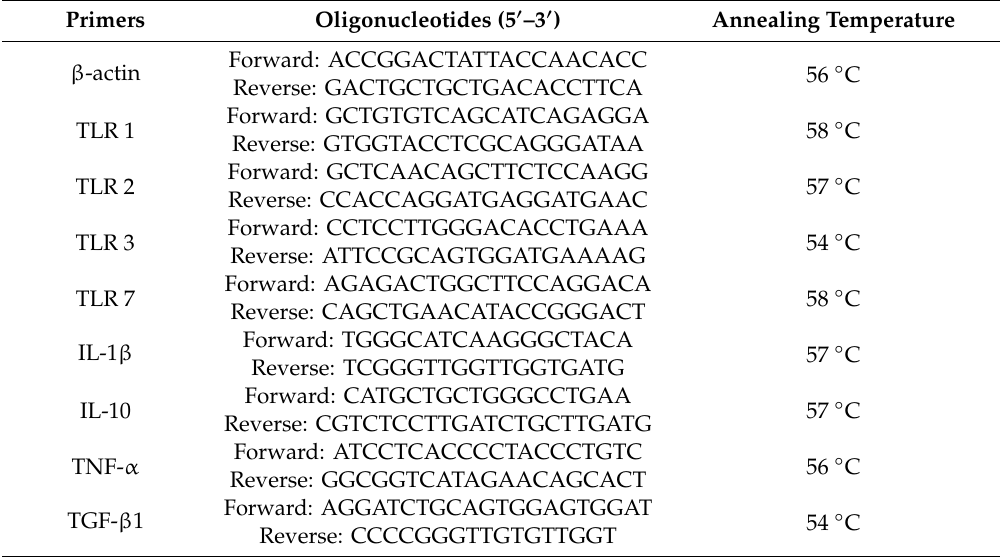
Table 3. Primers used in the qRT-PCR for quantification of TLRs and cytokine mRNA expression. Primers Oligonucleotides (5 (cid:48) –3 (cid:48) ) Annealing Temperature Forward: